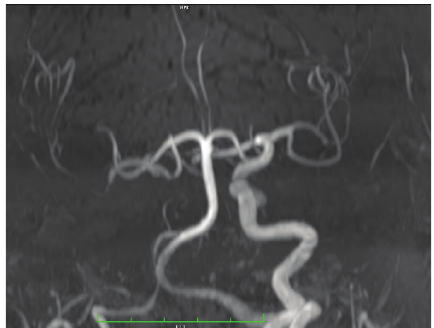
Figure 3: MR angiography image after